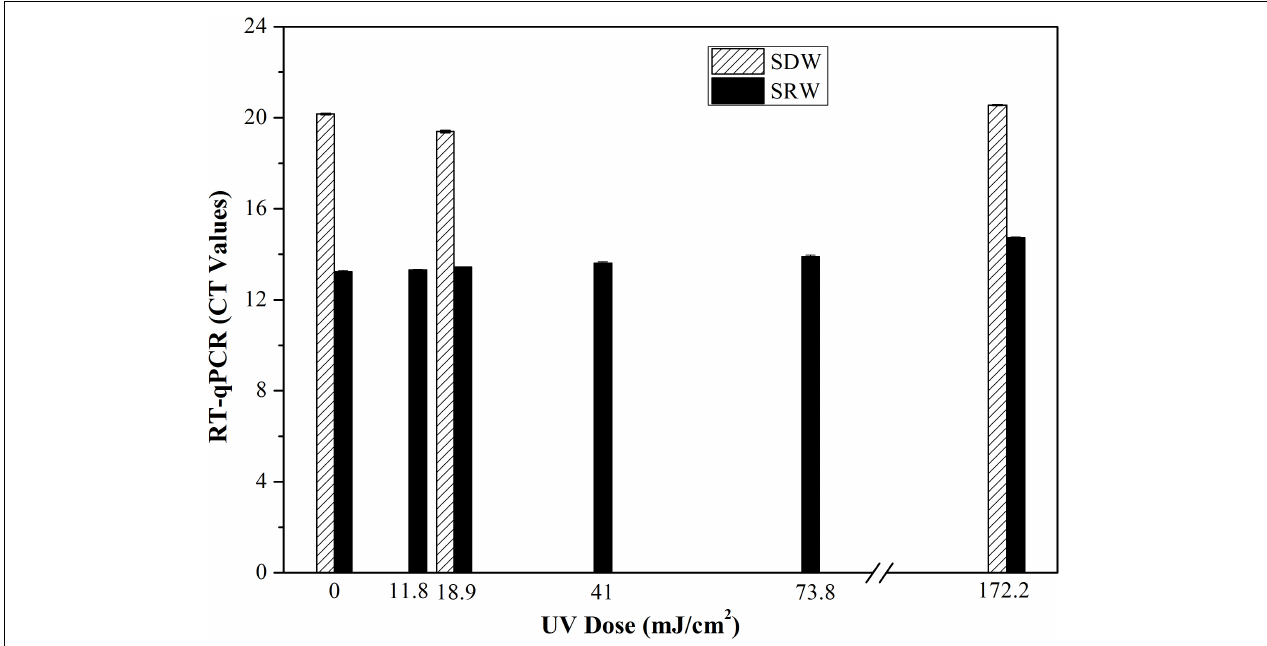
FIGURE 3 | Transcription or gene expression level of 16S rRNA of E. coli represented as Ct values after treatment with different UVC doses based on RT-qPCR. Mean values with standard deviation from three independent measurements were shown. SDW, simulated drinking water; SRW, simulated reclaimed water.